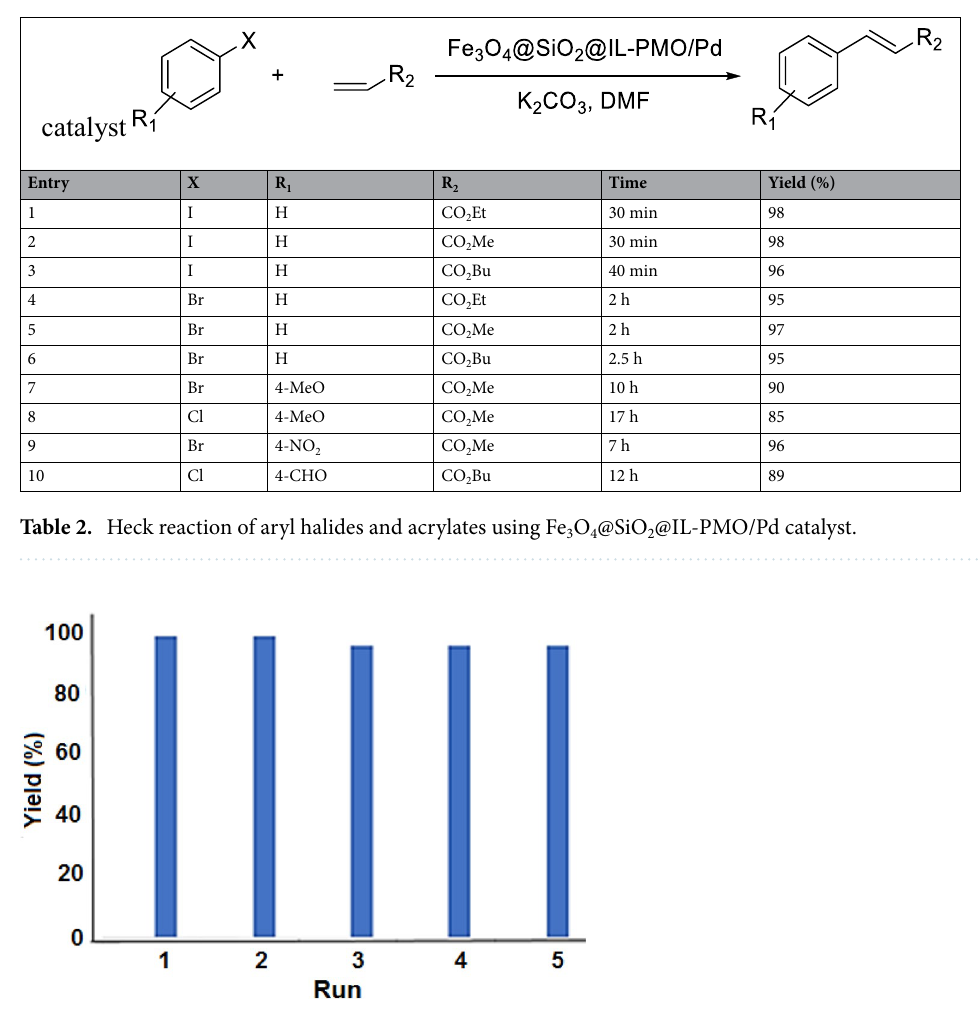
Figure 11. The recovery of Fe 3 O 4 @SiO 2